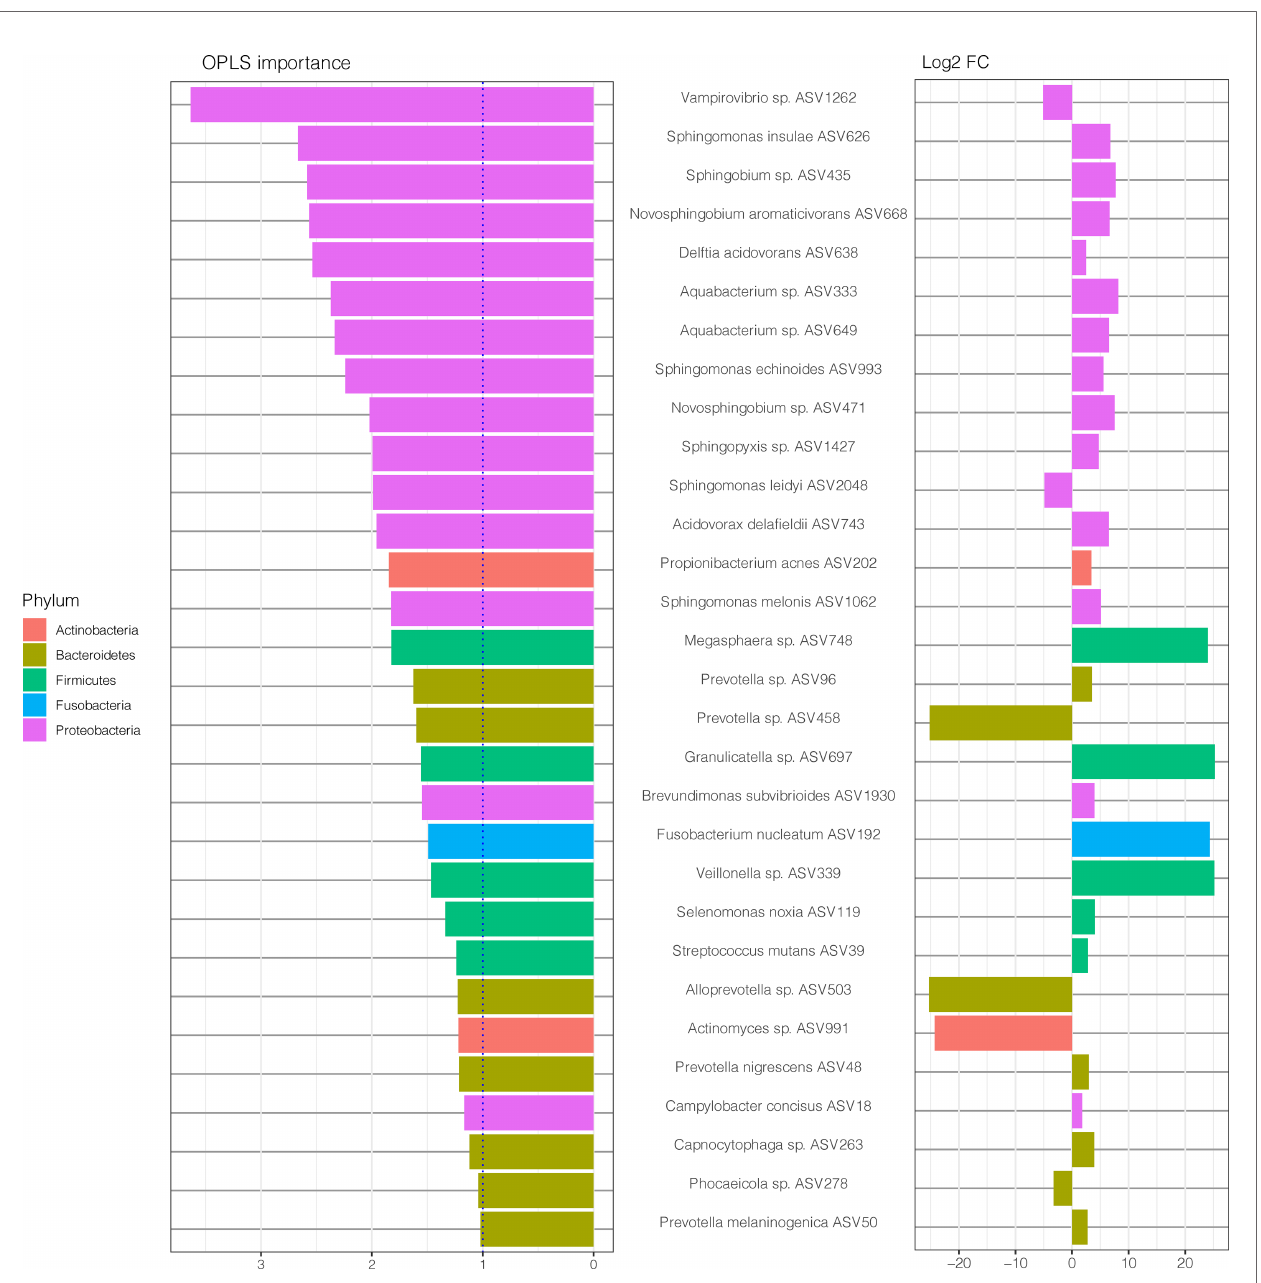
FIGURE 5 | Amplicon sequences variants (ASVs) identi fi ed by OPLS-DA analysis with variable importance higher than 1 together with the log2 fold change (log2 FC), for ASVs with p value < 0.05, performed with size factor normalization of fold changes as implemented in DESeq2. The lowest annotated taxonomic rank is shown for each ASV as well as the ASV IDs used for the